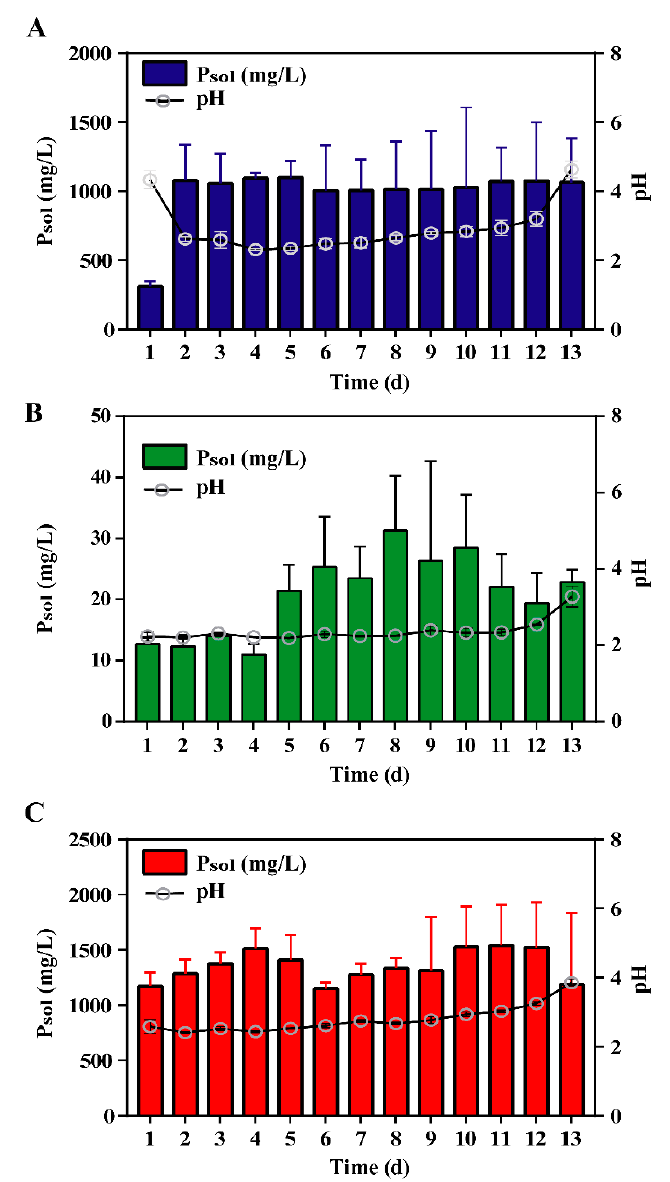
Figure 1. Changes of soluble-phosphorus (P sol ) by Penicillium oxalicum with ( A ) tricalcium phosphate, ( B ) iron phosphate, and ( C ) dipotassium phosphate as the sole P source during 13 days of culture. Data are the average result of three replicates with standard deviations.